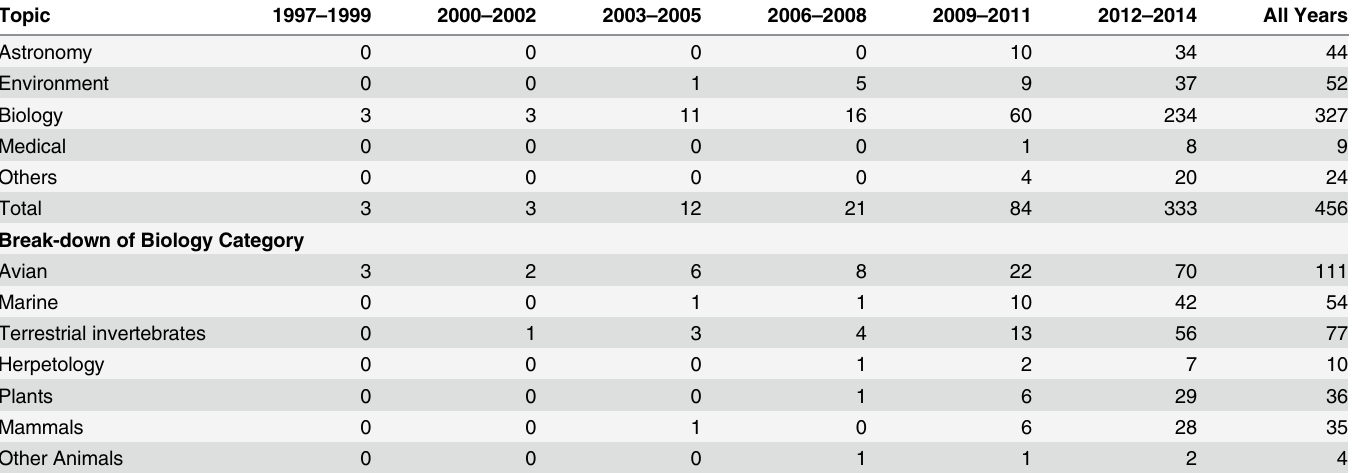
Table 3. The number of citizen science projects for each topic from 1997 to 2014.